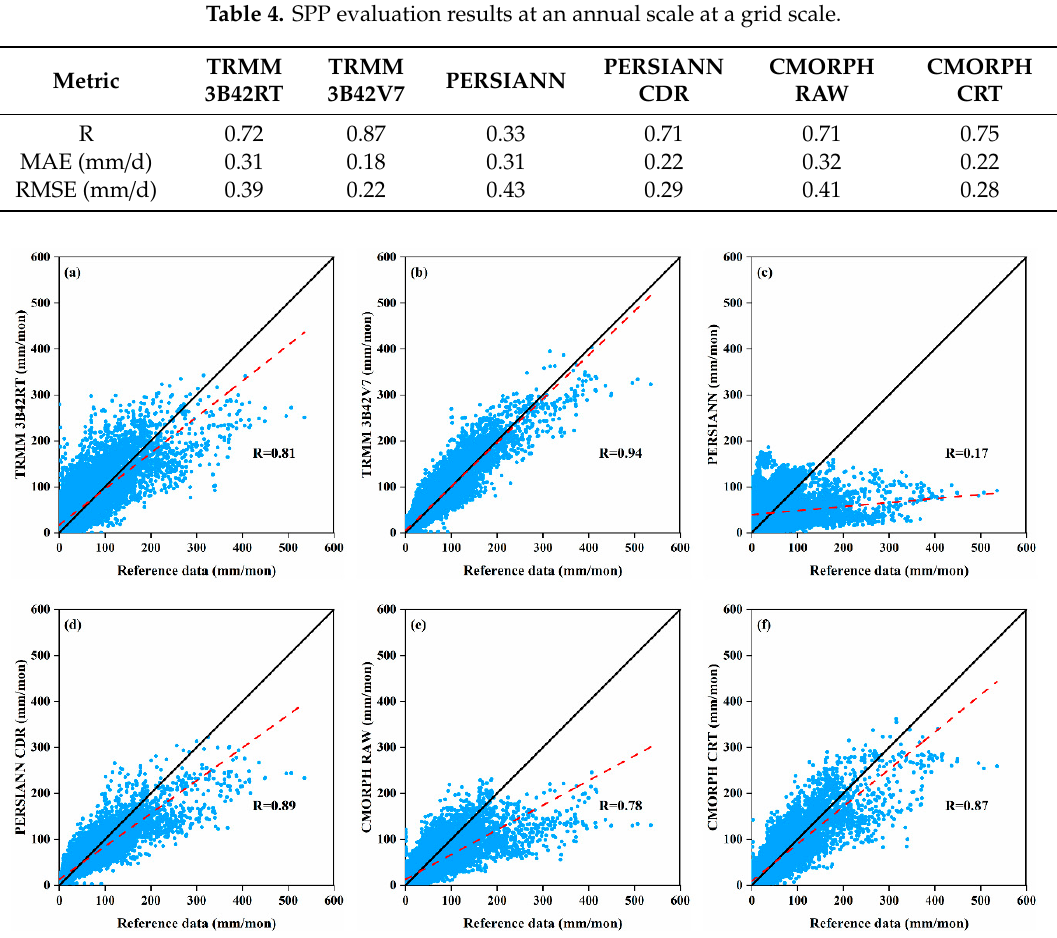
Figure 4. Monthly precipitation scatter plots for the reference data vs. the six SPPs ( a ) TRMM 3B42RT, ( b ) TRMM 3B42V7, ( c ) PERSIANN, ( d ) PERSIANN CDR, ( e ) CMORPH RAW and ( f ) CMORPH CRT at a grid scale.